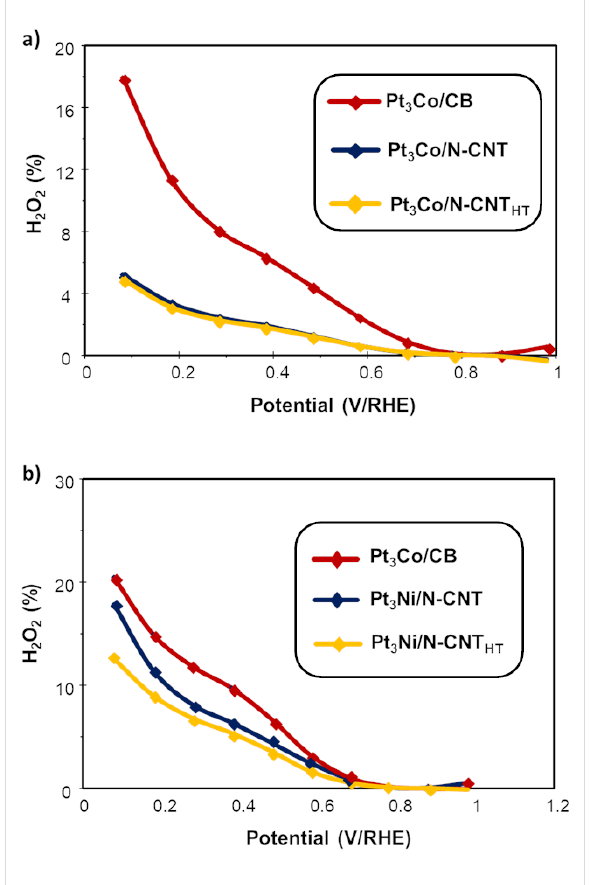
Figure 5: Percentage of H 2 O 2 formation during O 2 reduction of the a) Pt 3 Co and b) Pt 3 Ni